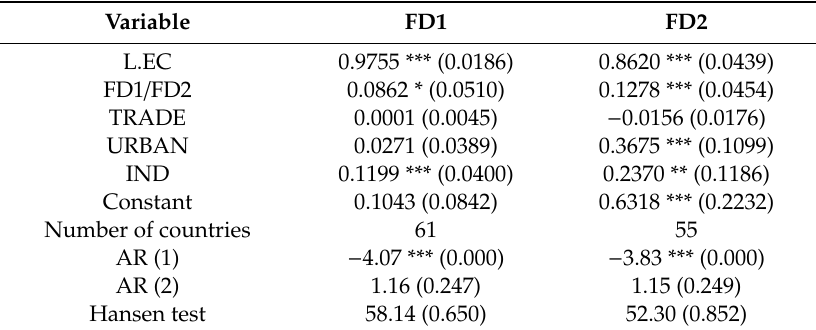
Table 10. Results of the full sample regressions with the longer